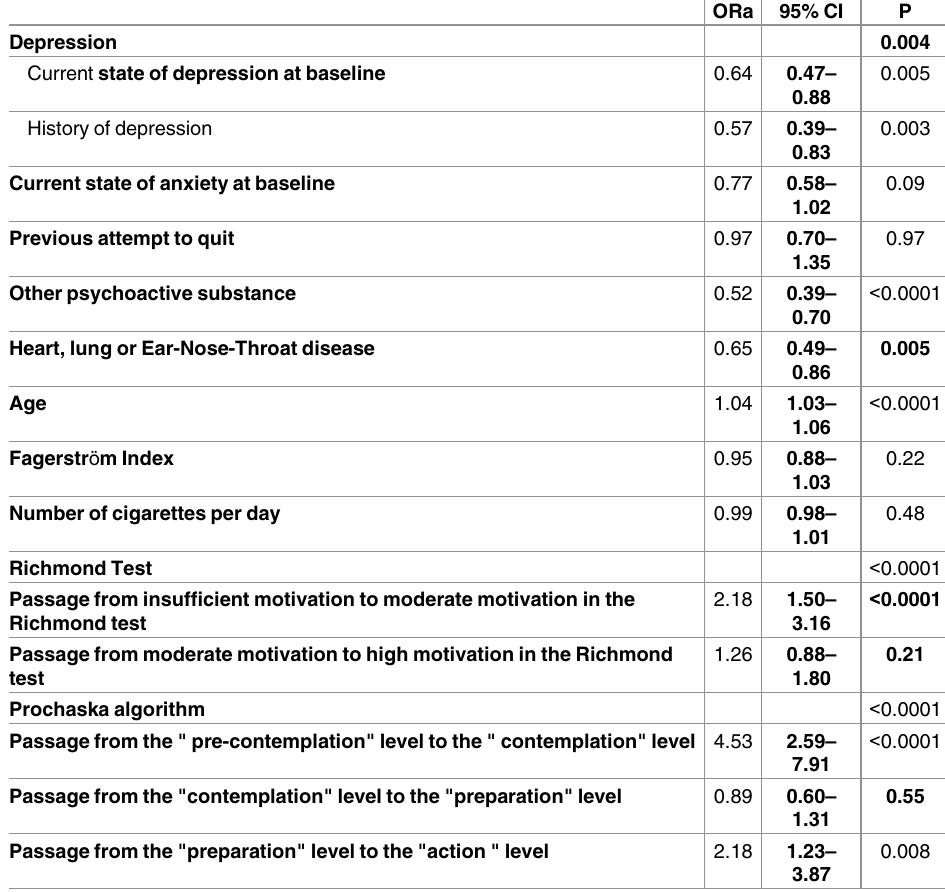
We computed correlation coefficients for all pairs of variables, and all were lower than 0.61. Depression remained a significant obstacle to abstinence (p = 0.004). In contrast, current state of anxiety at baseline, a previous attempt at smoking cessation, the Fagerstrom score and the number of cigarettes smoked every day were no longer significant in multivariate analysis. An older age was a highly significant positive factor for abstinence (p < 0.0001). The total score in the Richmond test (p < 0.0001) and the level in the Prochaska algorithm (p < 0.0001) remained highly significant, each of which had a positive impact on abstinence. The consumption of another psychoactive substance (p < 0.0001) or the presence of heart, lung or ENT disease (p = 0.005) remained highly significant barriers to abstinence. Two significant interactions were found by bivariate analyses: